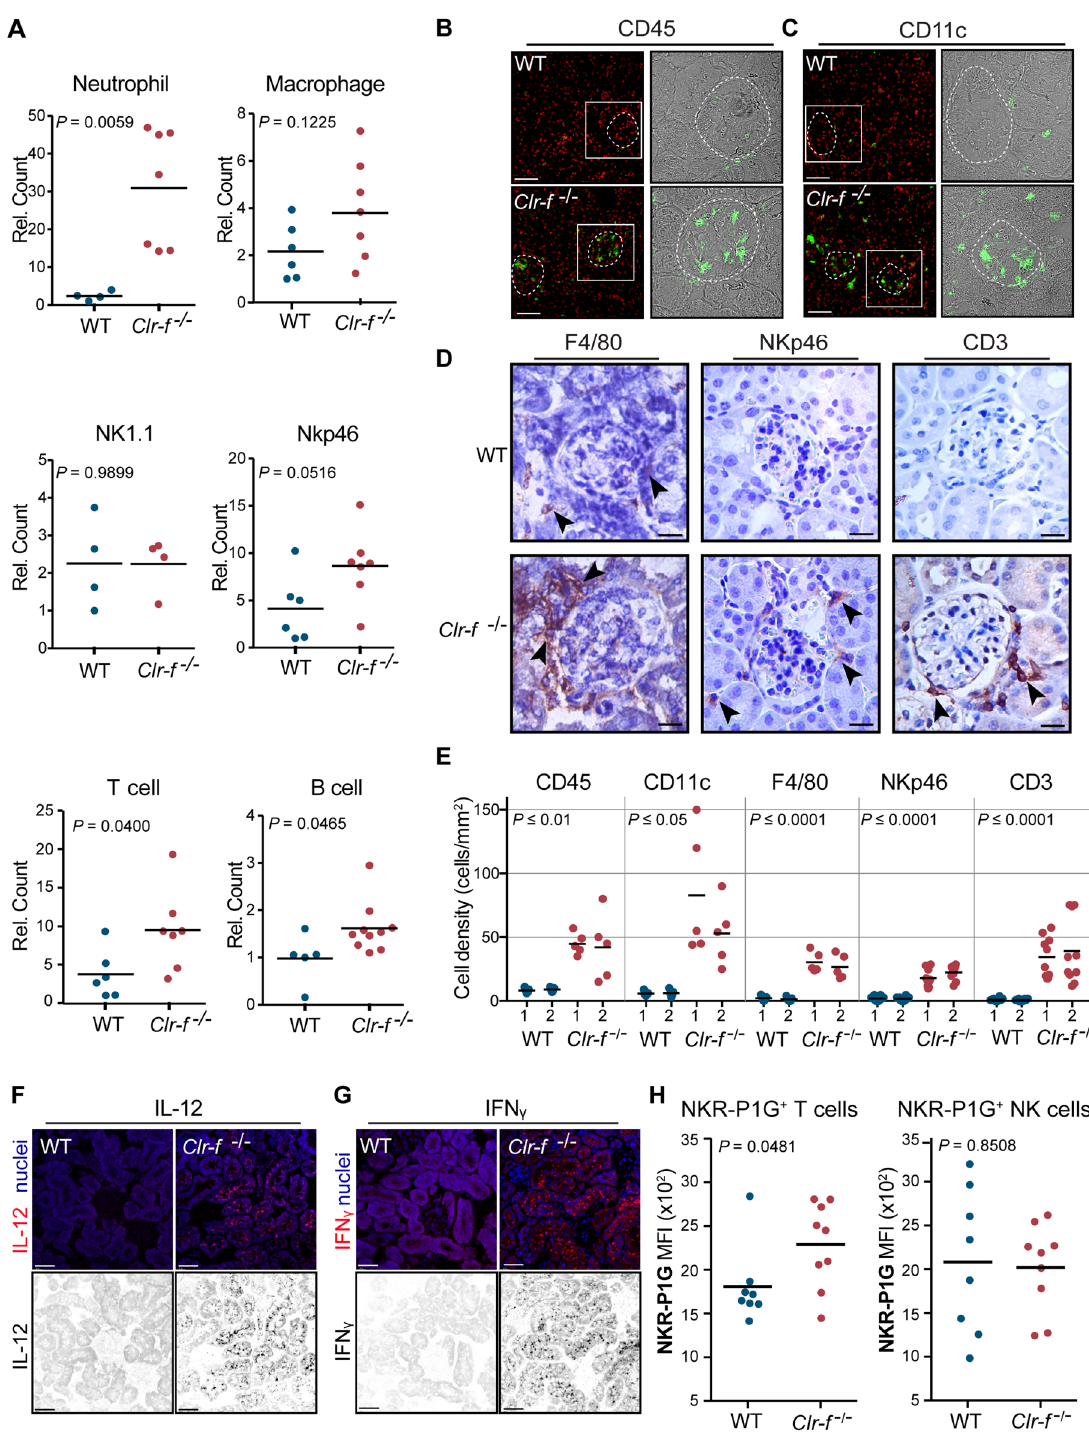
Figure 6. Presence of renal immune cells in kidney tissue in Clr-f −/− mice. ( A ) Flow cytometry analysis of neutrophil, macrophage, NK1.1 + cell, NKp46 + cell, T cell, and B cell numbers per the whole kidney of Clr-f −/− mice relative to WT mice at 12 weeks of age. Horizontal bars represent mean cell numbers. ( B ) IF staining of WT and Clr-f −/− mouse kidneys with anti-CD45 antibody or ( C ) anti-CD11c antibody and DAPI nuclear staining (in red). Glomeruli are indicated by white-dashed lines. Brightfield panels of select glomeruli are shown with CD45 + or CD11c + cells shown (in green). Scale bars represent 40 μm. ( D ) IHC staining of WT and Clr- f −/− mouse kidneys with antibodies against F4/80, NKp46, and CD3. Black arrowheads indicate select IHC positive cells. Images are captured at 20 × magnification. Scale bars represent 40 μm. ( E ) Visual quantification of indicated immune cell type per field from kidney sections of two WT and two Clr-f −/− mice. Each dot represents an individual field count and horizontal bars represent mean cell numbers. ( F ) IF staining of kidney sections for IL-12 and ( G ) IFNγ cytokines in WT and Clr-f −/− mice. Scale bars represent 40 μm. ( H ) NKR-P1G mean-fluorescence intensity (MFI) on kidney TCRβ + T cells and NK1.1 + NK cells measured by flow cytometry analysis. Horizontal bars represent mean cell numbers and error bars represent standard